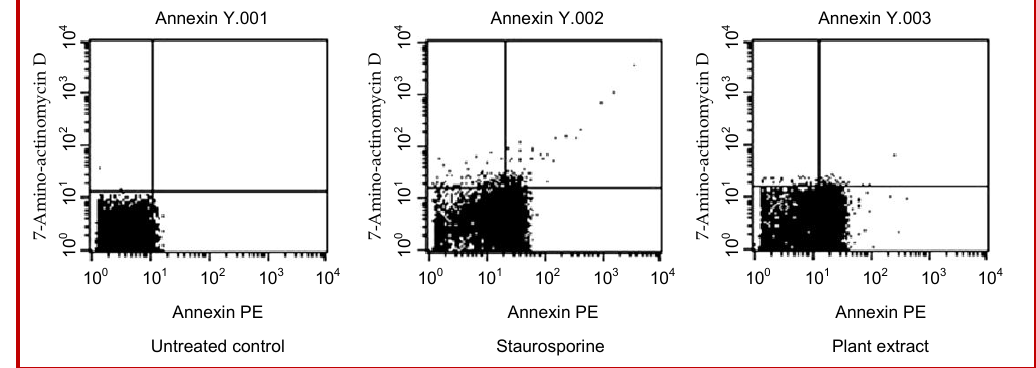
Figure 2: Annexin V-PE apoptosis assay of CHO cells treated with T. violacea aqueous crude extract (0.5 mg/mL) for 1 hour, 1 µM staurosporine was used as a positive control for apoptosis. In the untreated control, the cell population is confined within the first quadrant boundaries. For the positive control and the plant extract, the dot plot shows that there was an increase in the Annexin V -PE staining (horizontal axis). The absence of the 7-AAD staining (vertical axis) means no